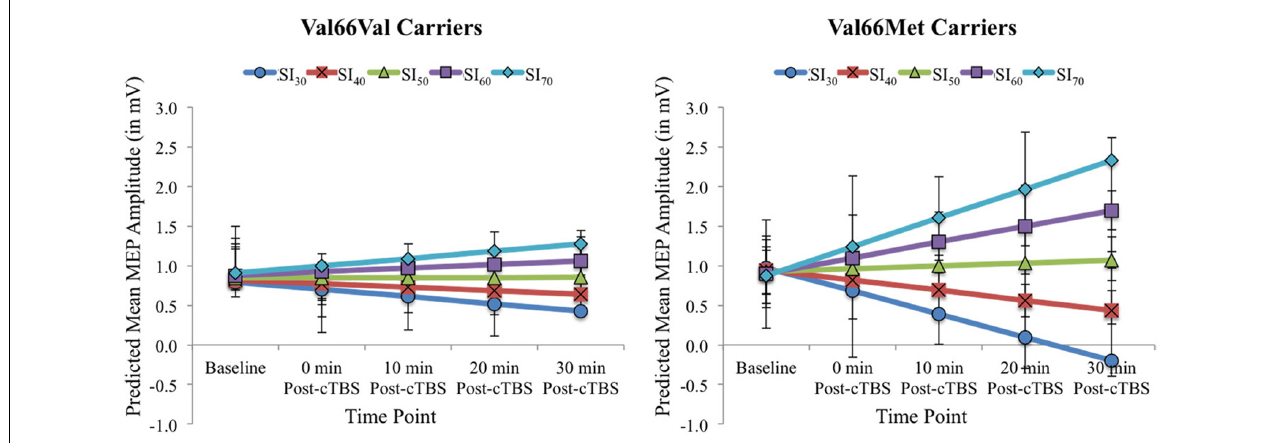
FIGURE 2 | Model-estimated (predicted) MEP amplitudes (in mV) as a function of Time Point (Baseline vs. 0, 10, 20, and 30 post-cTBS) and SI 1mV (expressed as the percentage of maximum stimulator output [MSO] separated into 10% increments across the range of SI 1mV values as depicted in different colors) for Val66Val (left) and Val66Met carriers (right). Error bars represent 95% confidence